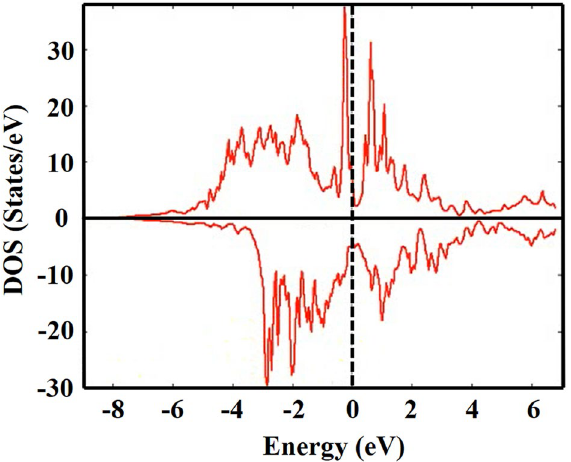
Figure 1. The spin-up and spin-down electronic density of states (DOS) for YFe 3